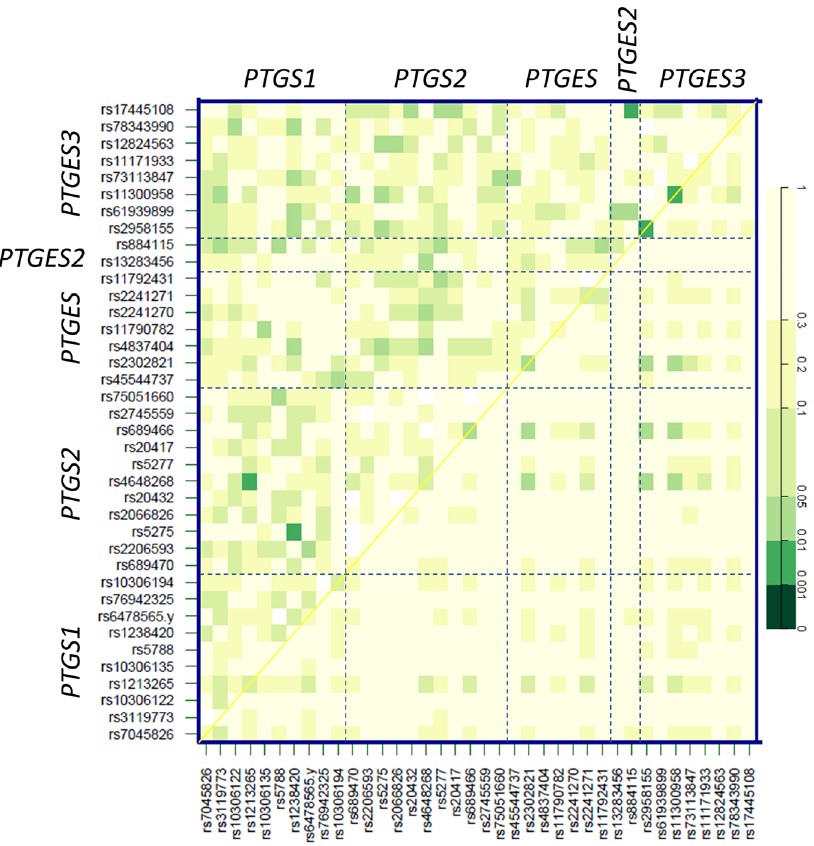
Figure 4. Interactions between genetic variants in the cyclooxygenase-PGE2 pathway and their association with cardiovascular events in nephrosclerosis patients. The upper triangle in the matrix contains p-values for the interaction (epistasis) log-likelihood ratio test. The lower triangle contains p-values from likelihood ratio test comparing the two-SNP additive likelihood to the best of the single-SNP models.